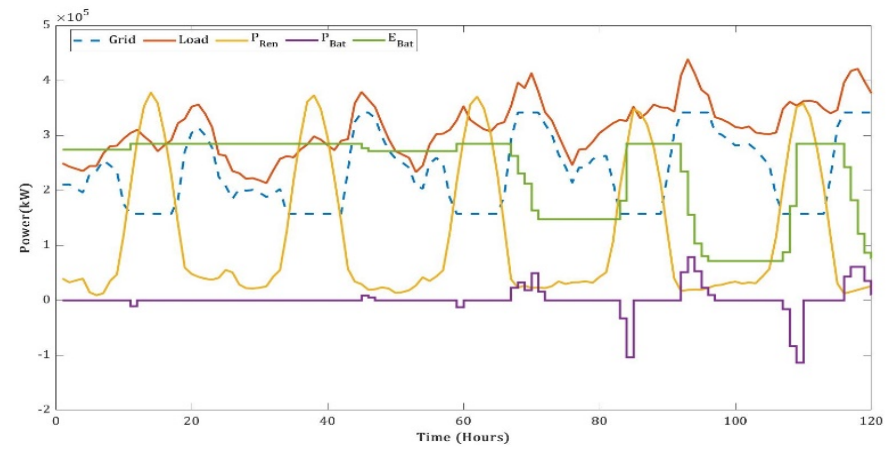
Energies 2021 , 14 , 5368 Figure 13. Power distribution with ALA-QPSO for the minimum LPSP for 21–26 March. Figure 13. Power distribution with ALA-QPSO for the minimum LPSP for 21–26 March. Figure 13. Power distribution with ALA-QPSO for the minimum LPSP for 21–26 March.